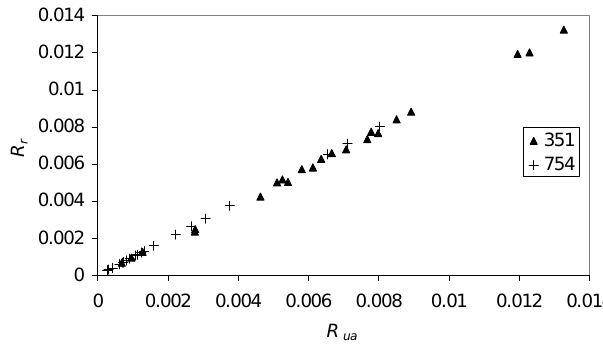
Figure 3. The upward radiance reflectance in air, R r , as a function of the total upward reflectance in air, R ua , at 351 and 754nm.